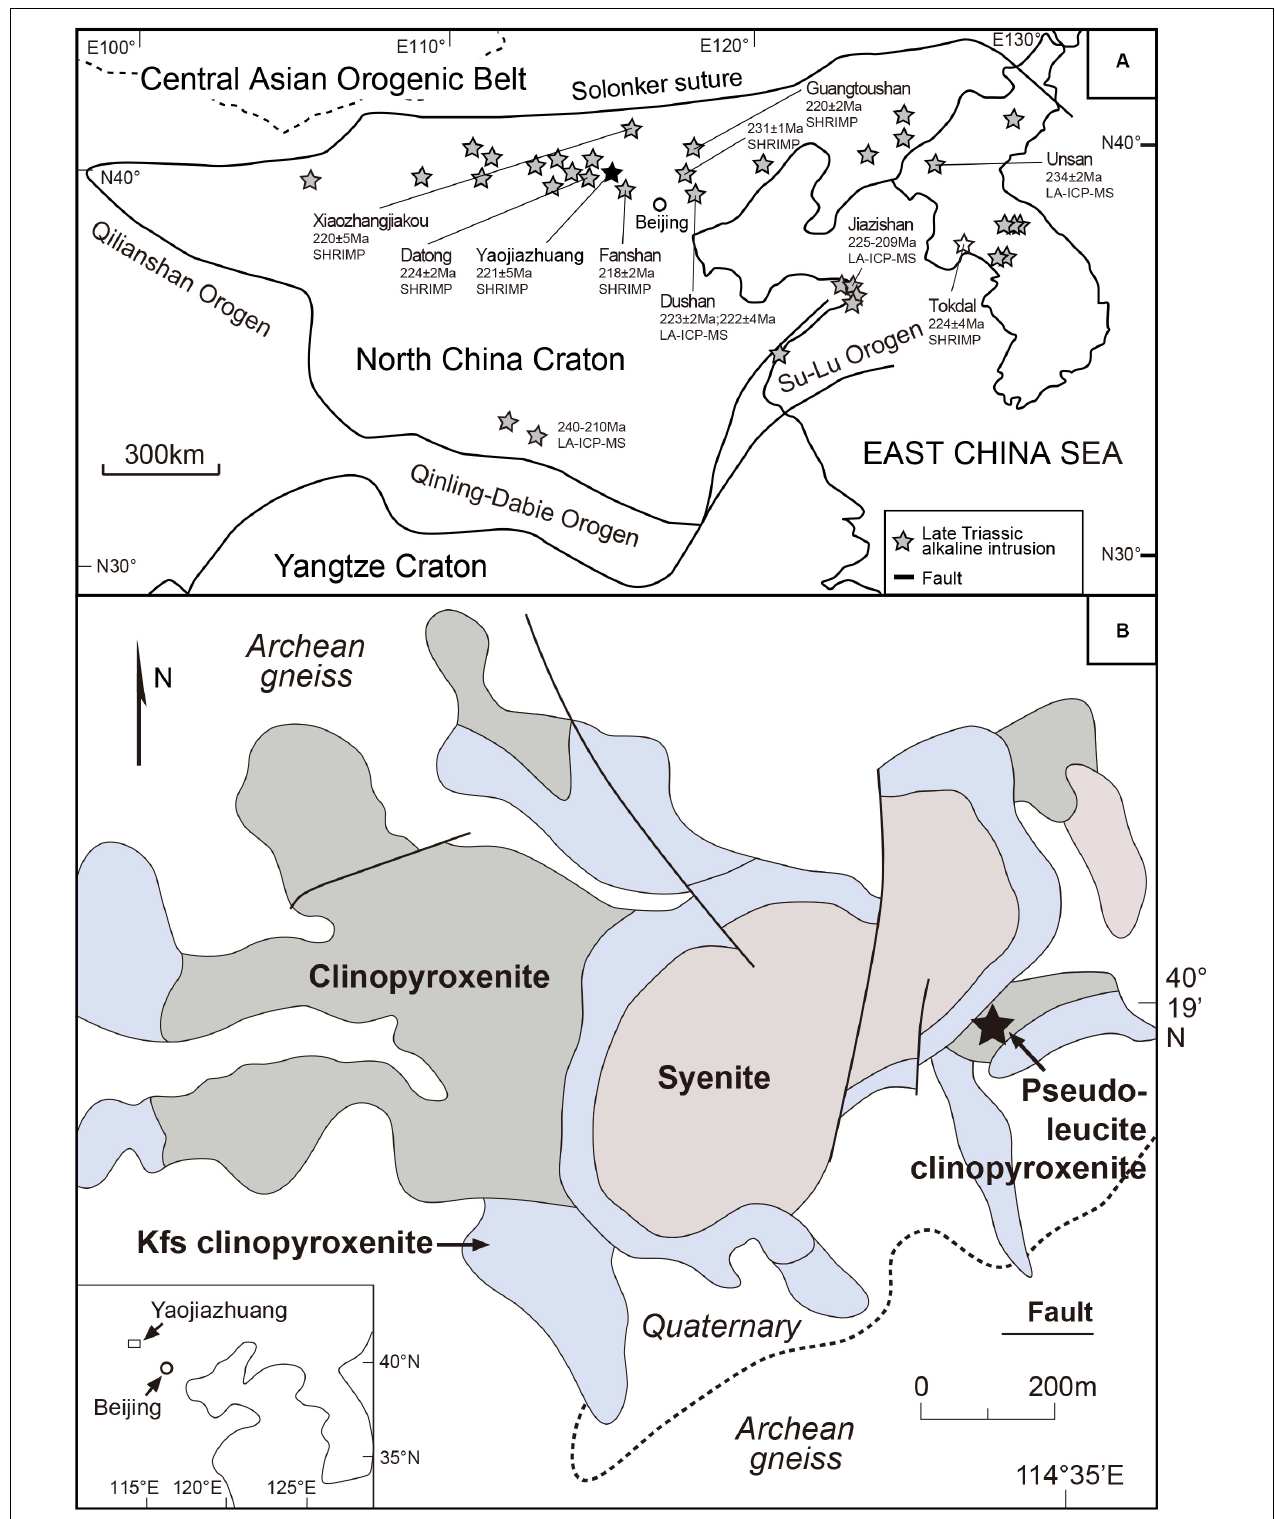
FIGURE 1 | (A) Simplified tectonic map showing the distribution of Late Triassic alkaline intrusions in North China Craton (modified from Ren et al., 2009). Labeled ages and analytical methods are compiled from Zhang et al. (2012) and references therein. (B) Geological map of Yaojiazhuang ultrapotassic complex modified from Hou